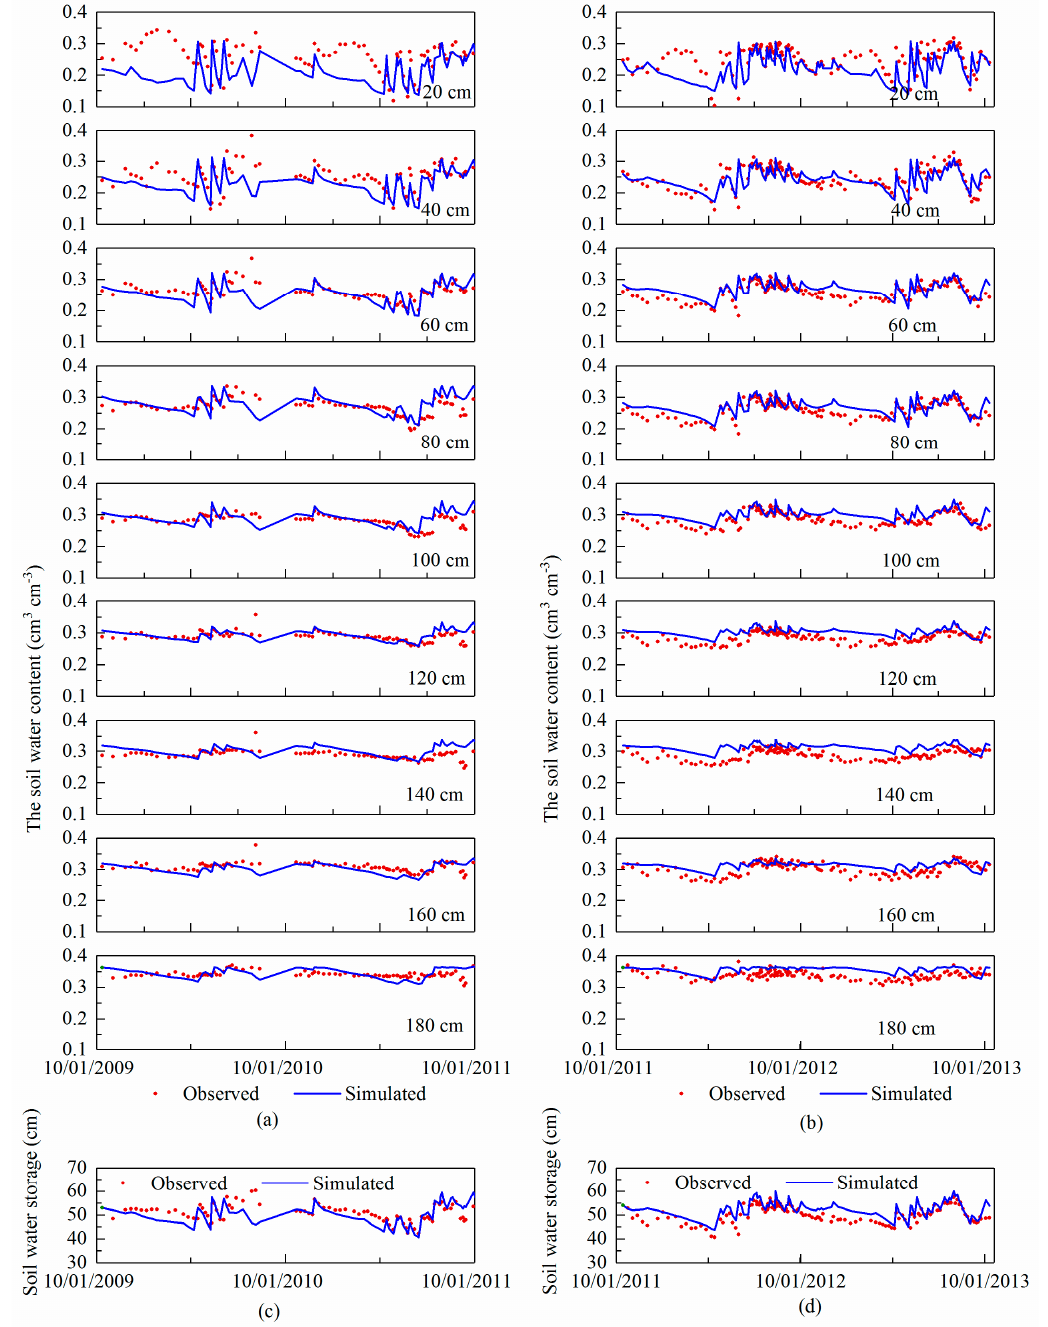
Figure 2. Comparisons of observed and simulated soil water content in the 0–180 cm soil profile and soil water storage for calibration ( a , c ) and validation ( b , d ).